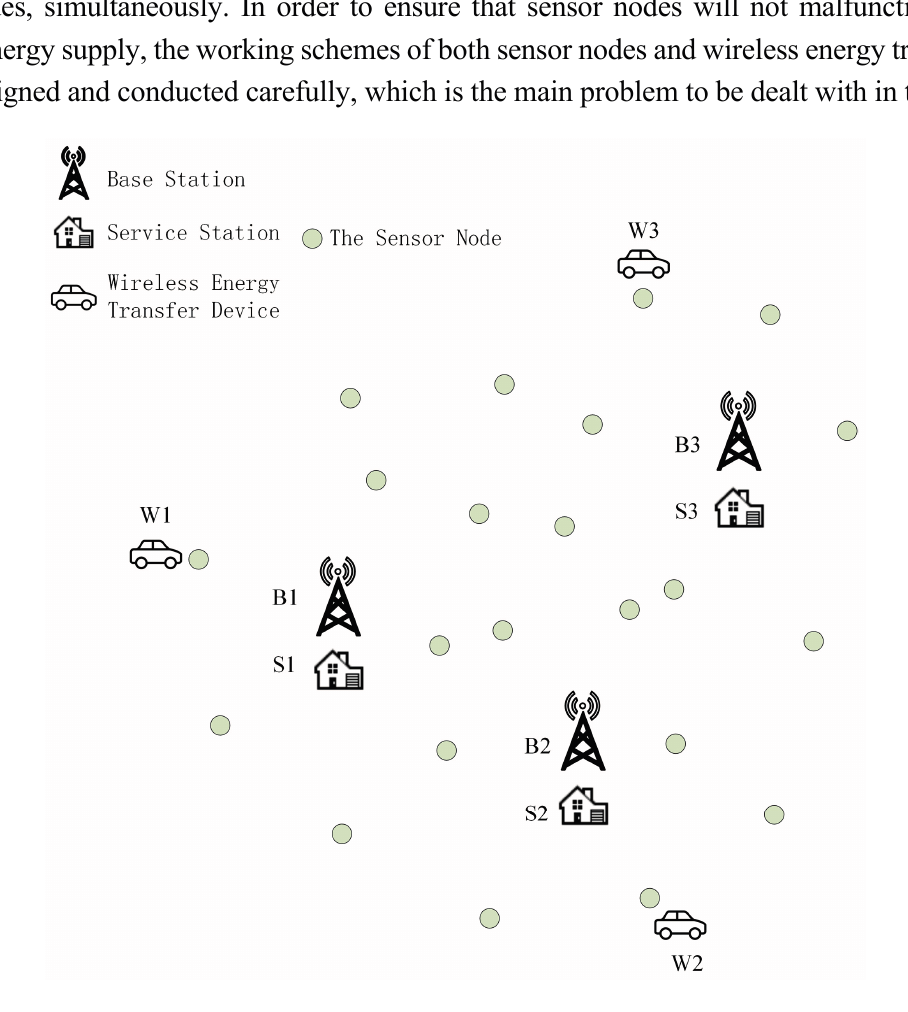
Figure 1. The wireless sensor network with multiple base stations and wireless energy transfer